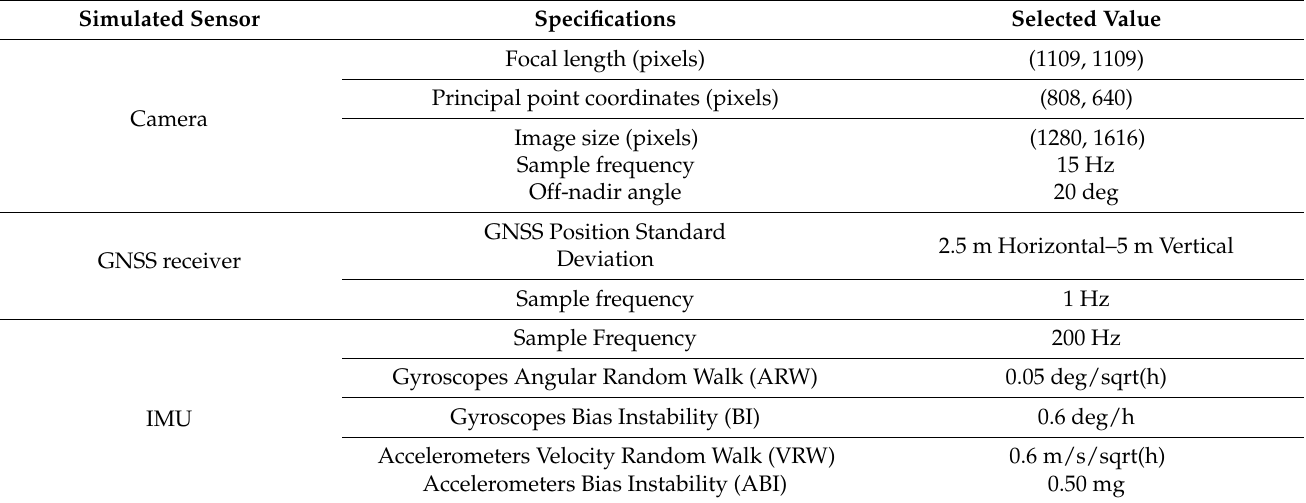
Table 2. Specifications of the simulated